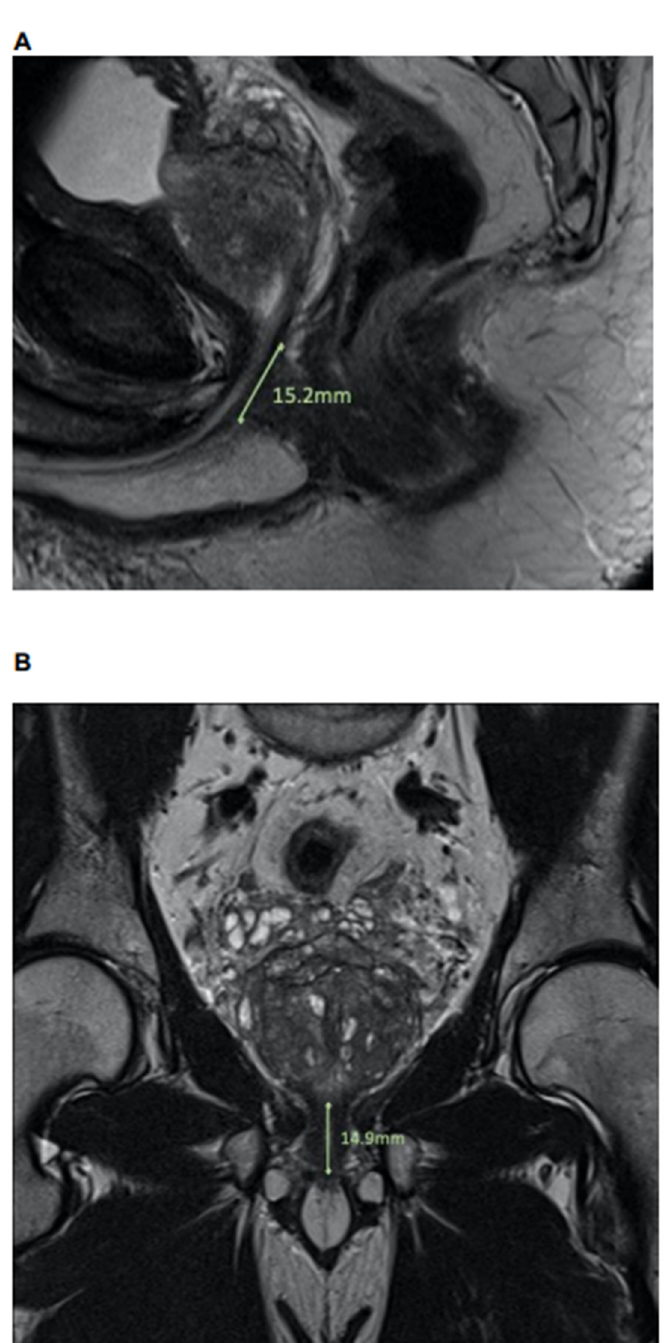
Figure 1. Urethral sphincter length measurements in ( A ) sagittal and ( B ) coronal dimensions in a multiparametric MRI prior to radical prostatectomy.